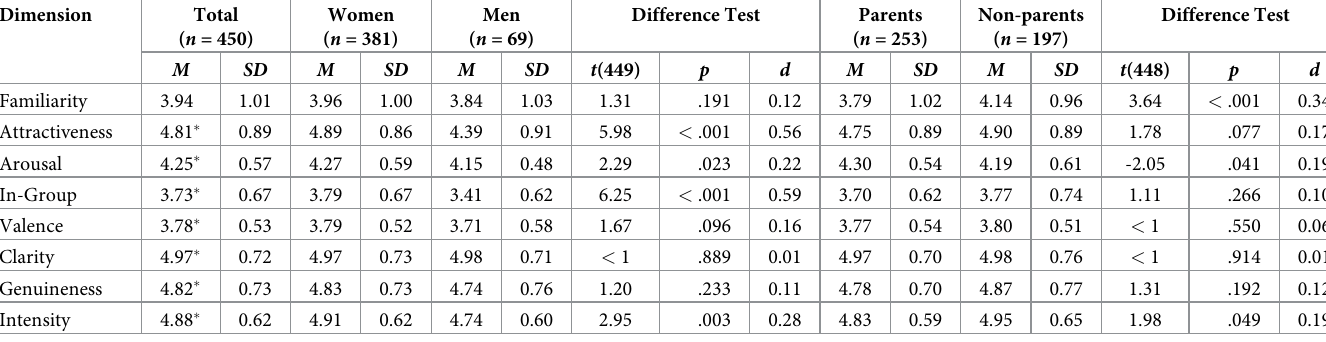
Table 4. Mean evaluations across dimensions (entire sample; for women vs. men; for parents vs. non-parents).